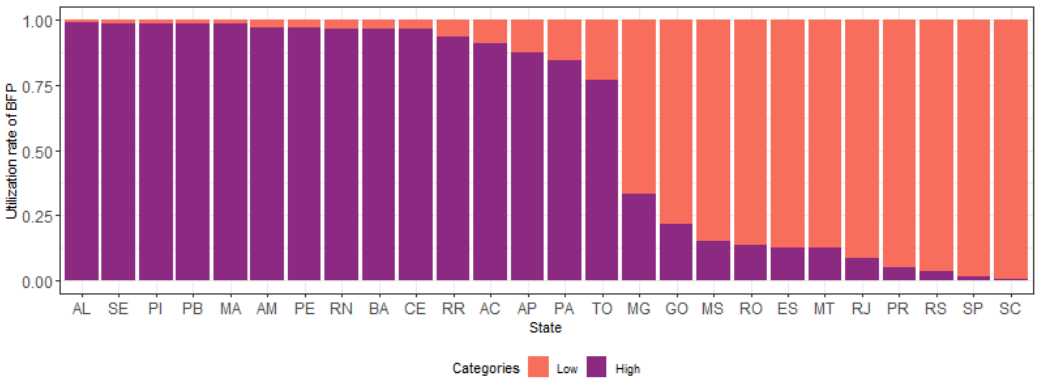
Figure 4. Map of the average city use rates of the BFP in 2019, for 2 classes. Source: prepared by the authors.